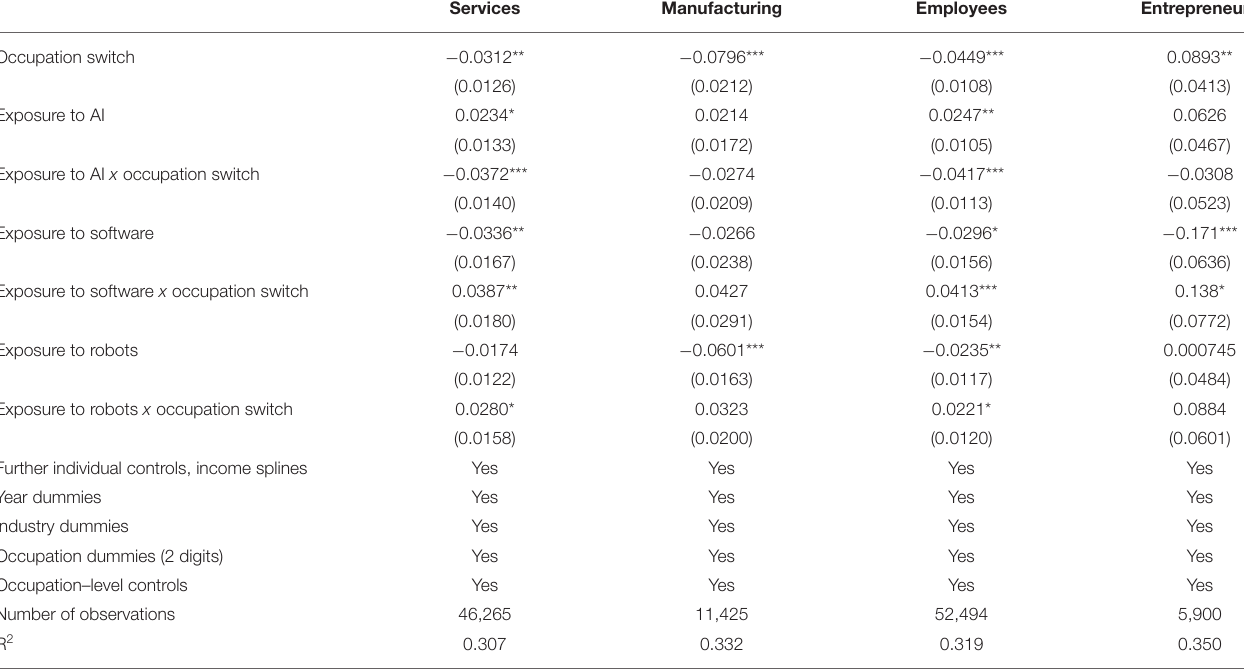
TABLE 4 | Technology exposure and annual wage growth by sector and employment